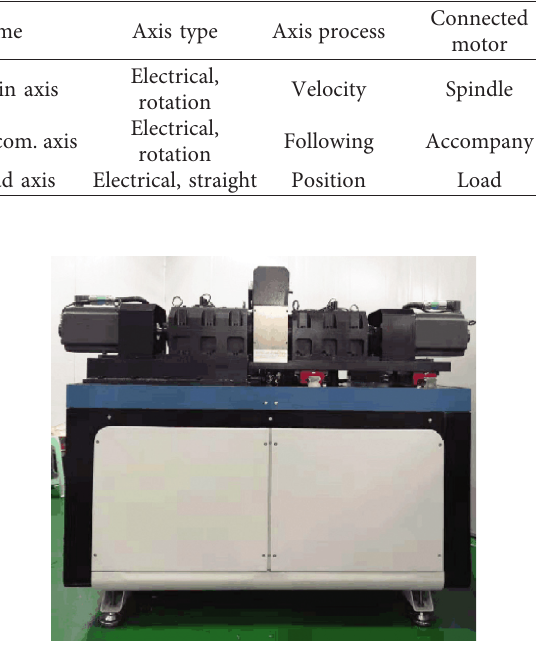
Figure 12: Experimental site environment.